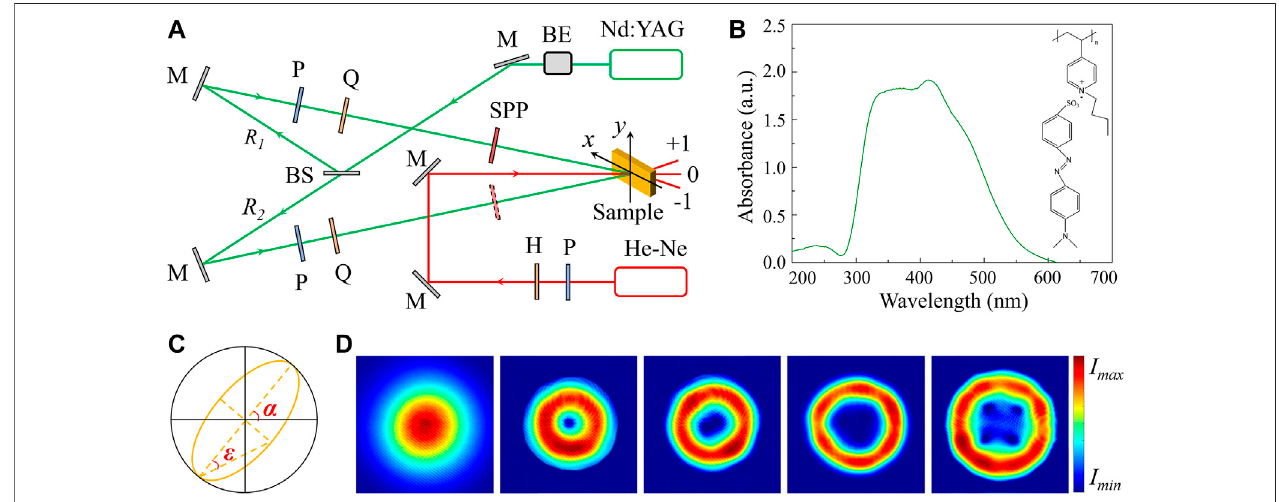
FIGURE 1 | (A) Schematic setup of orbital polarization holography. BE, beam expander; M, mirror; BS, beam splitter; P, polarizer; Q, quarter-wave plate; H, half- waveplate;SPP,spiralphaseplate. (B) Absorptionspectrumandmolecularstructureofthephoto-alignmentliquid-crystalline fi lm. (C) Diagramofthepolarizationellipse with α being the azimuth and ε being the ellipticity. (D) Spatial intensity distribution of the recording light with TC of 0, 1, 2, 3 and 4 (from left to right) measured by CCD.